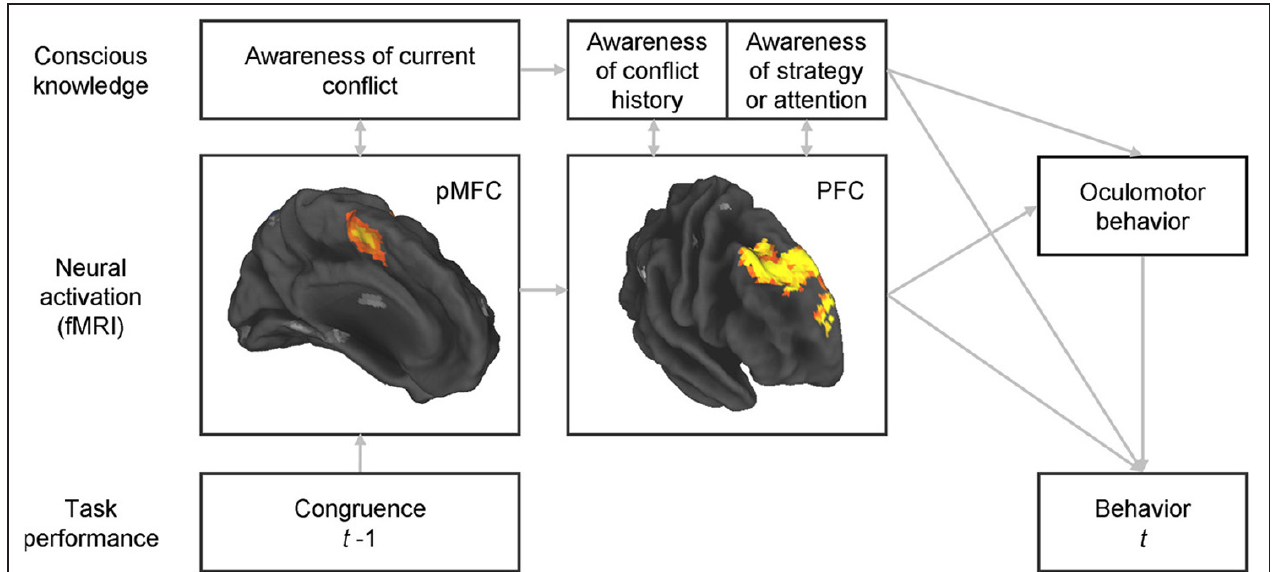
adjustments in oculomotor behavior that potentially reflect an expectancy of a certain type of stimulus are associated with conscious knowledge of such expectancy and of its effect on the allocation of spatial attention; and (3) whether behavioral adjustments (of oculomotor behavior or of choice and reaction times) are fully mediated by conscious knowledge or whether instead they can be adaptively influenced by neural activity in the PFC without accompanying conscious knowledge (as predicted by our hypothesis that neural activity in these circuits can be causally efficacious even it is not accompanied by conscious knowledge). pMFC, posterior medial frontal cortex (encompassing the dorsal anterior cingulate cortex and the pre-supplementary motor area); PFC, prefrontal cortex (specifically, rostral dorsomedial, and dorsolateral prefrontal